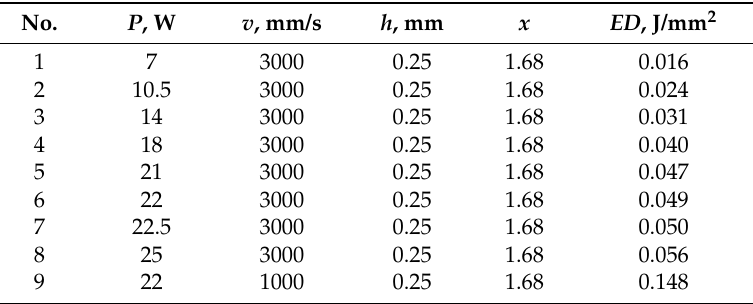
Table 4. Processing parameters with different energy.